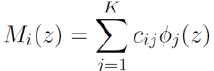
Figure. 3. The division of a subsoil according to the idea of functional data analysis. Figure 3: The division of a subsoil sample according to the concept of functional data